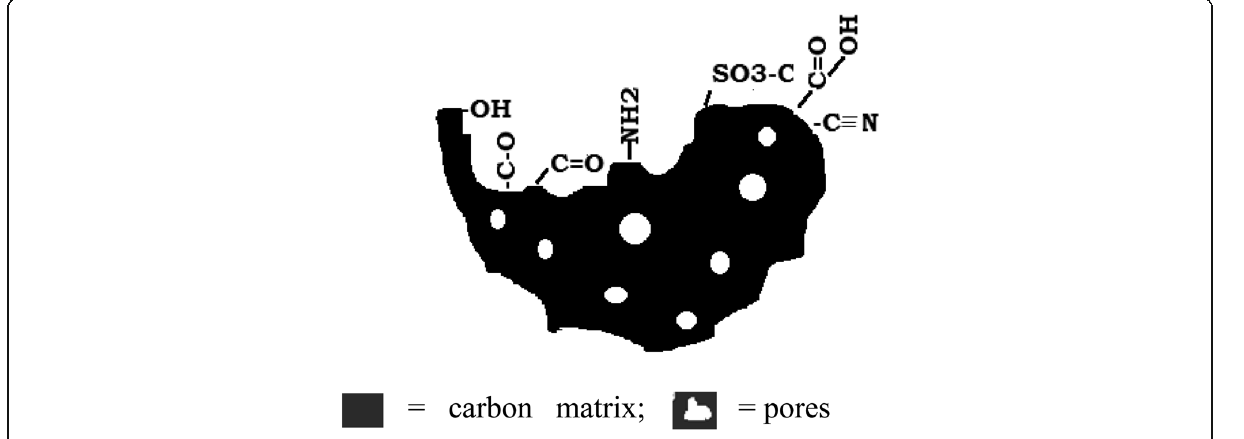
Fig. 7 Model of various organic functional groups on the surface of the activated carbon. = carbon matrix; =